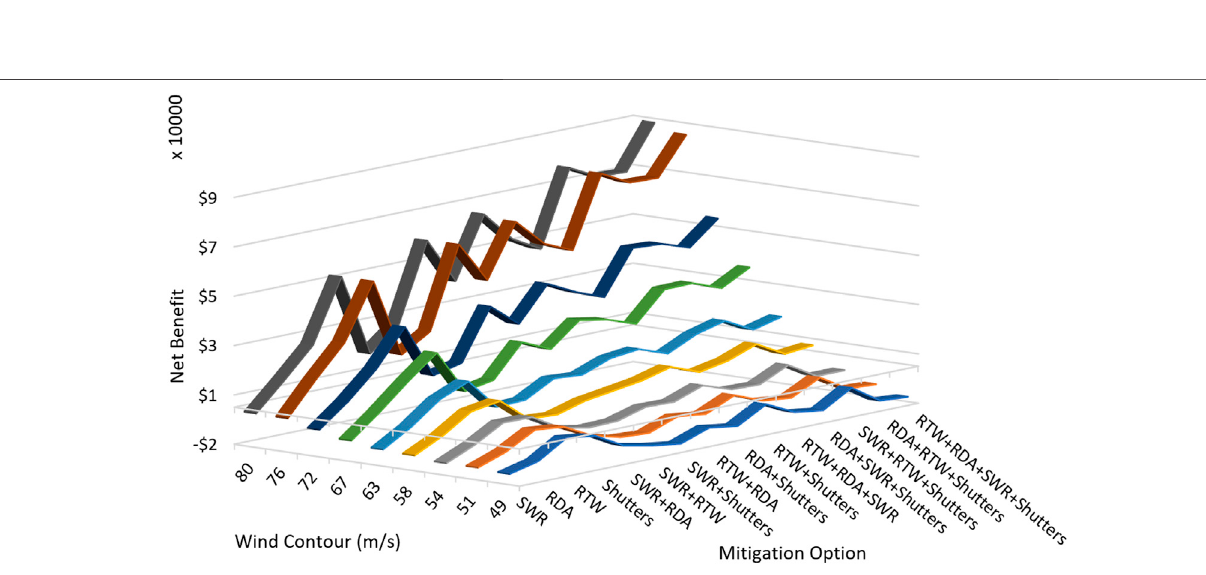
FIGURE 5 | Net bene fi t of wind hazard mitigation strategies for a 30-year time horizon based on ASCE 7 wind speed contours using retro fi t construction cost.